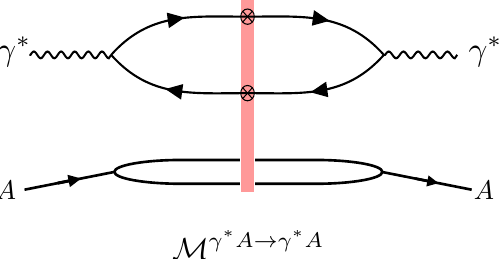
γ ∗ A γ ∗ A of virtual photon– → M γ ∗ A γ ∗ A ) . In the high-energy limit, the → M